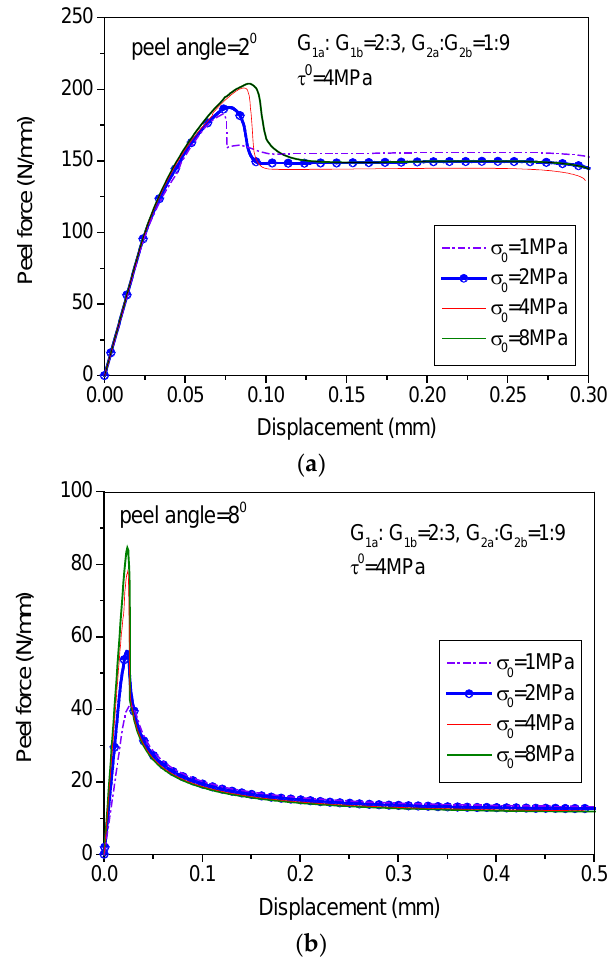
Figure 12. Effect of normal peak strength on the load-displacement behavior: ( a ) peel angle = 2 degree; ( b ) peel angle = 8 degree.